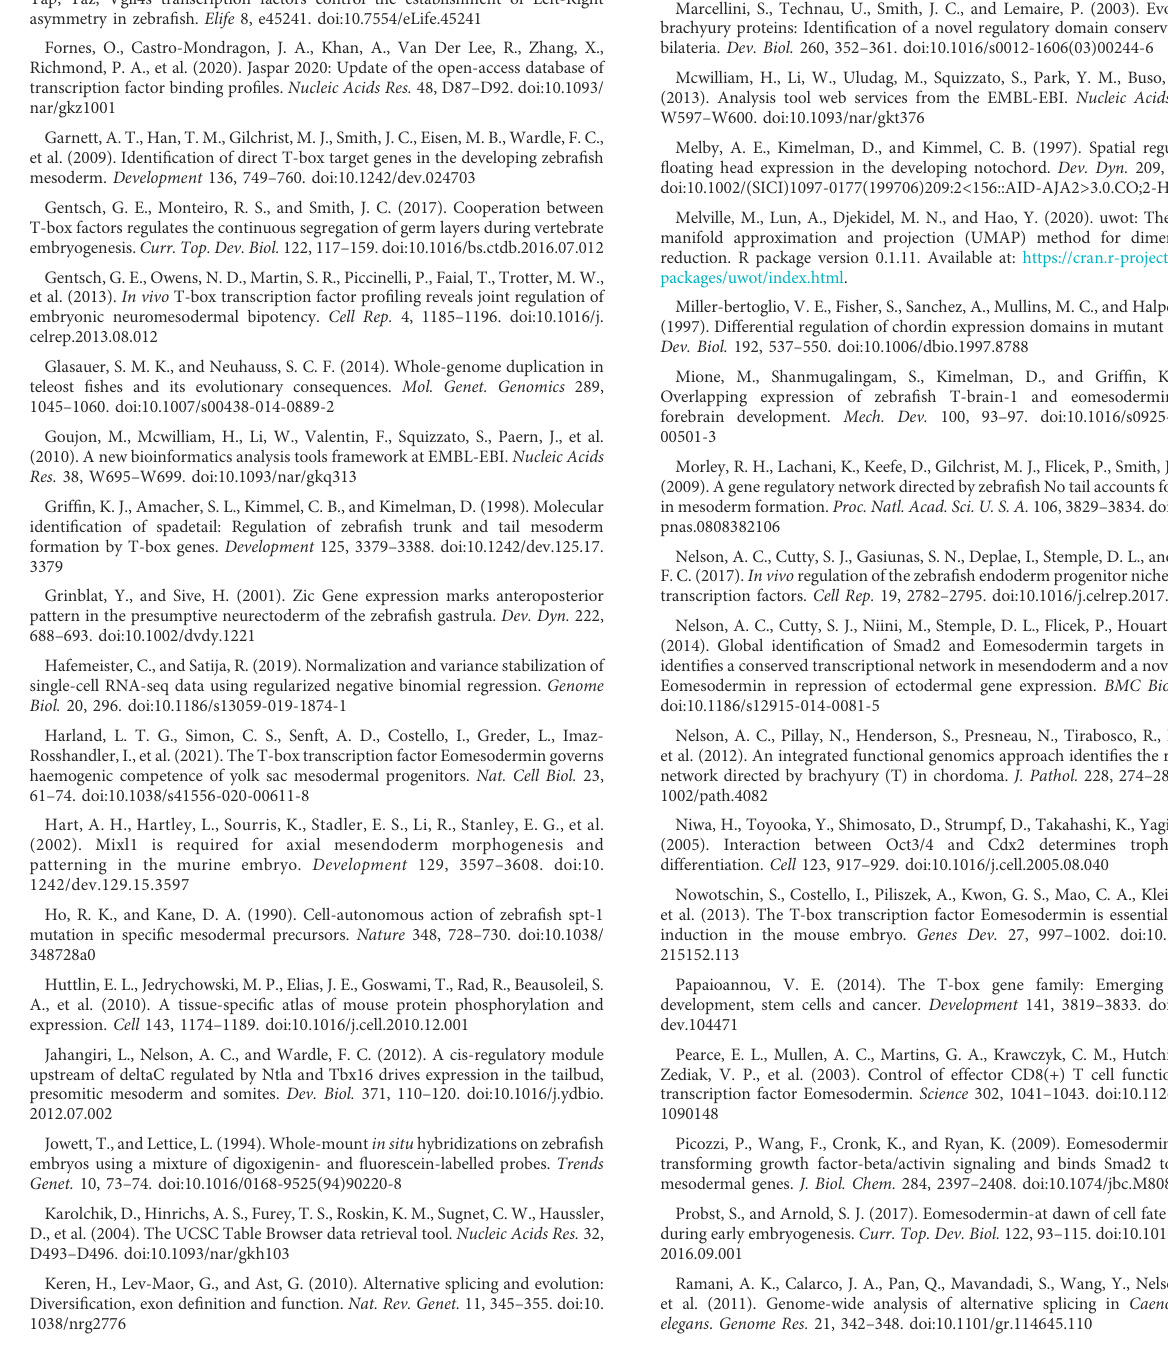
Figiel, D. M., Elsayed, R., and Nelson, A. C. (2021). Investigating the molecular guts of endoderm formation using zebra fi sh. Brief. Funct. Genomics 20, 394 –